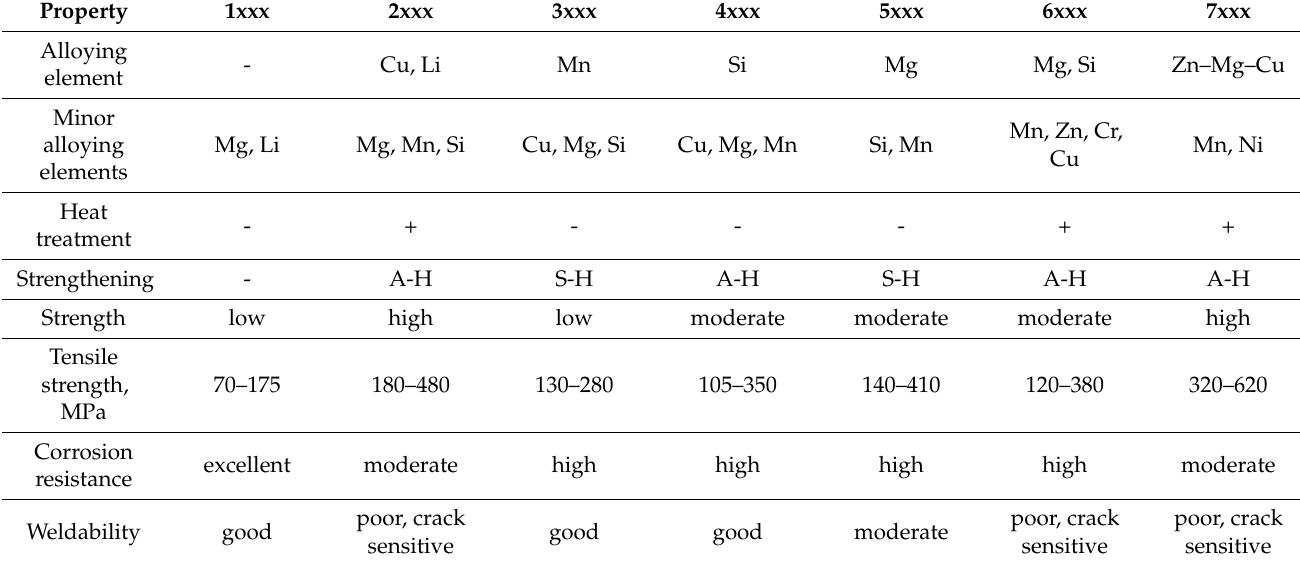
Table 1. Classification and characteristics of wrought aluminium alloys. Note: most alloys (including 1xxx) have some elements such as Fe, Ti, or Cr in very low amounts (<0.01–0.05 wt.%) as residuals. A-H is age-hardening and S-H is strain-hardening